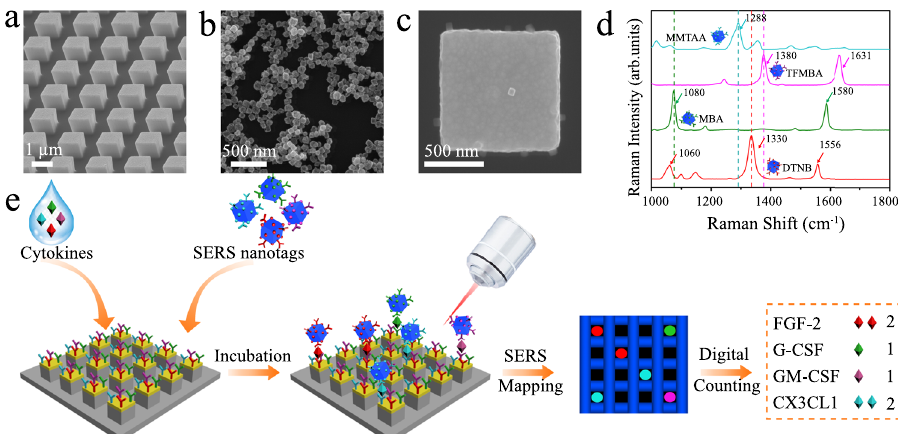
Fig. 1 Digital single-molecule nanopillar surface-enhanced Raman scattering (SERS) platform for parallel counting of four types of cytokines. SEM images of a pillar array side view, b nanoboxes, and c a single nanobox on the top of a pillar; d SERS spectra of nanoboxes conjugated with 5,5-dithiobis (2-nitrobenzoic acid) (DTNB), 4-mercaptobenzoic acid (MBA), 2,3,5,6-tetra fl uoro-4-mercaptobenzoic acid (TFMBA), or 2 ‐ mercapto ‐ 4 ‐ methyl ‐ 5 ‐ thiazoleacetic acid (MMTAA) Raman reporters; e work fl ow for multiplex counting of cytokines, including fi broblast growth factor 2 (FGF-2), granulocyte colony-stimulating factor (G-CSF), granulocyte-macrophage colony-stimulating factor (GM-CSF), and fractalkine (CX3CL1). Data from one independent